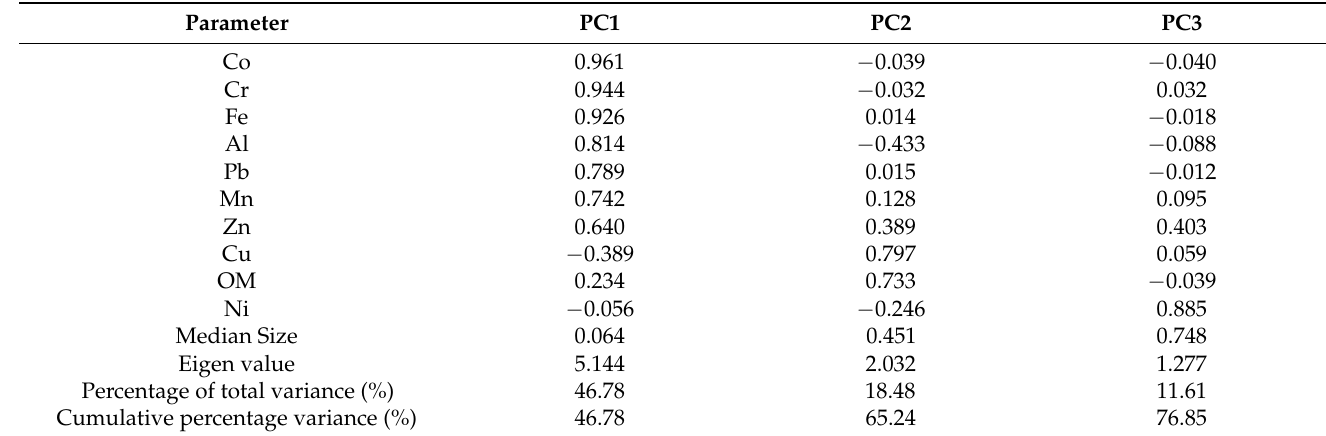
Table 2. Principal component analysis results (rotated component matrix and total variance interpre-